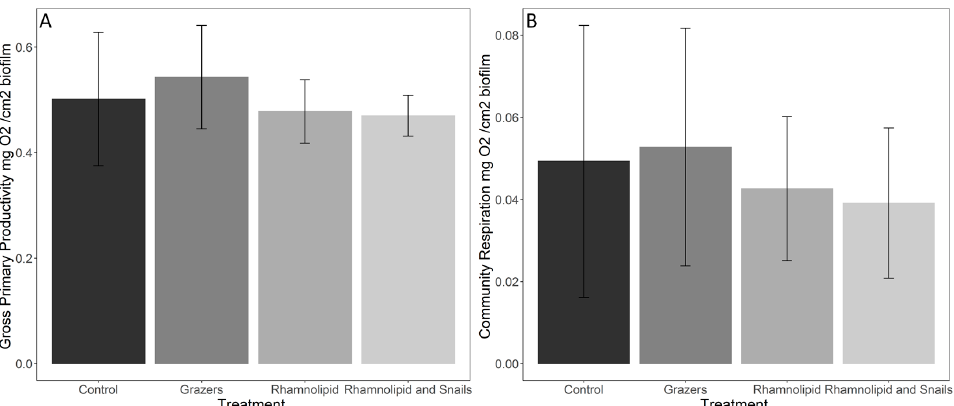
Figure 1. Gross primary productivity ( A ) and community respiration ( B ) of marine microbial biofilms exposed to either predation by the common periwinkle snail and/or 150 ppm rhamnolipid for 14 days. N = 8 ± SD.